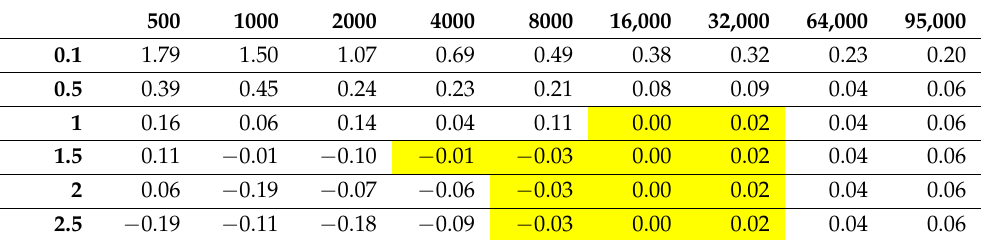
Figure 8. Convergence analysis for the triangular simplified models. In yellow, the results gone to convergence are expressed in percentage in relation to the result given by the analysis and the analytical result calculated for the specimen. Expressed in a graph. (Left is ERROR PERCENT). Table 7. Convergence analysis for the models simplified using retopology with the adaptive size fixed at 30. Highlighted in yellow are the results on convergence expressed in percentage in relation to the result given by the analysis and the analytical result calculated for the specimen.